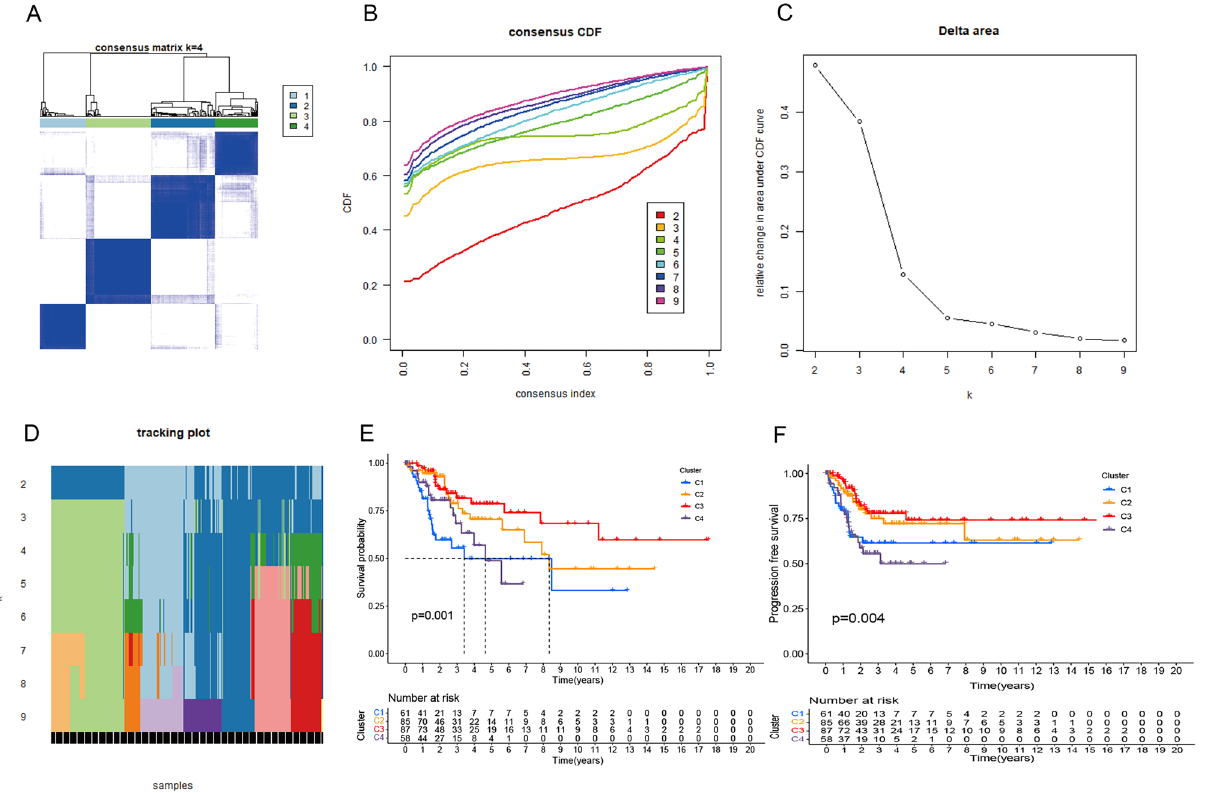
Figure 3. Genotyping of CESC cells based on their response to necroptosis-related gene sets. ( A ) Consensus clustering matrix of the 291 CESC samples with k = 4. ( B ) Consensus cluster CDF from k = 2 to k = 9. ( C – D ) Relative change in the area under curve CDF from k = 2 to k = 9. ( E – F ) Kaplan–Meier method survival analysis of four